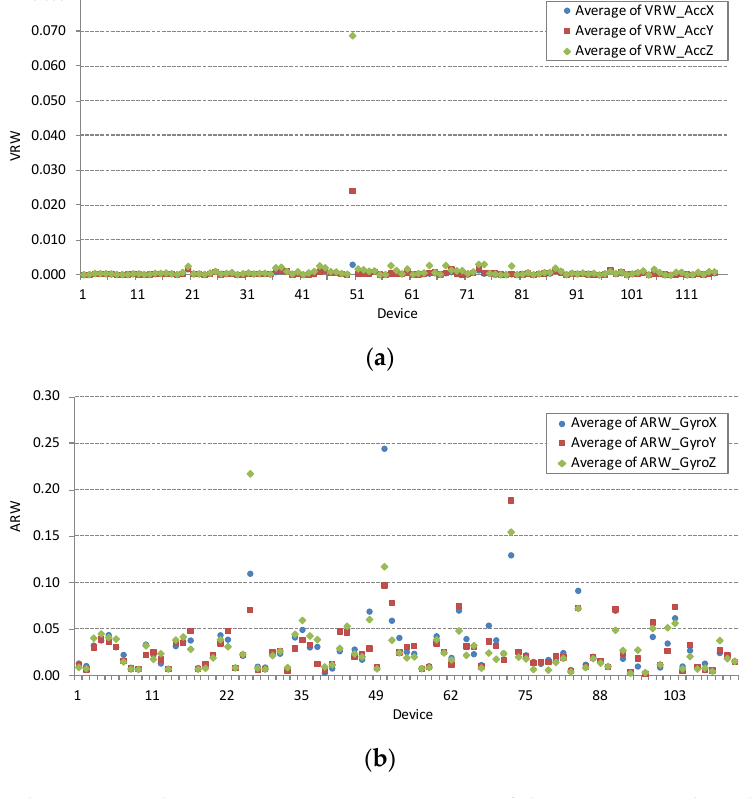
Figure 3. Accelerometer and gyroscope noise measurements of the axes X , Y and Z . The horizontal axis represents the device identification number from the measurement database. ( a ) The complete accelerometer measurement dataset is plotted, including an example of a faulty device with ID = 50 that evidently deviates from other devices. The vertical axis shows VRW in [g 0 / Hz ]; ( b ) The complete gyroscope measurement dataset is plotted, including the examples of the three faulty devices with ID = {25, 50, 73}. The vertical axis shows ARW in [deg/s/ Hz